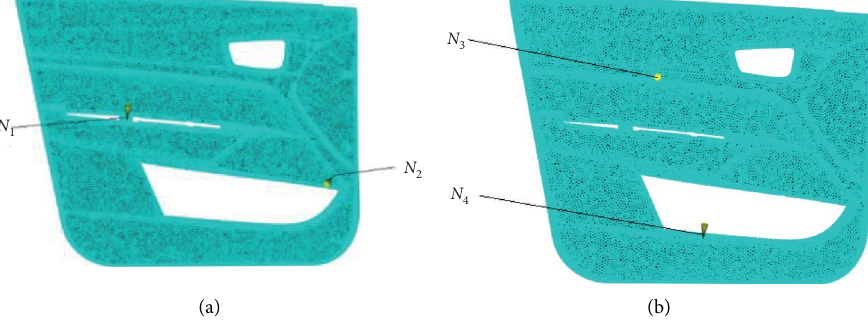
Figure 12: Gate position comparison diagram. (a) Initial gate position. (b) Optimized gate position.